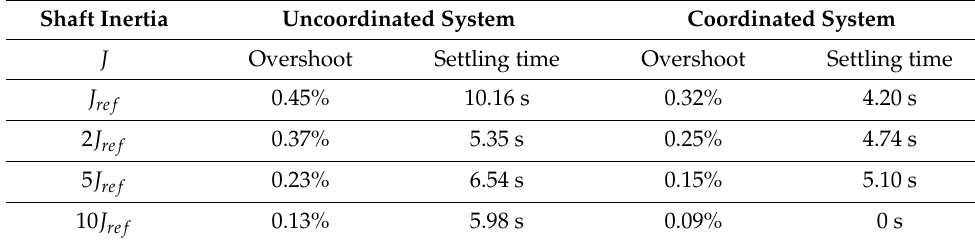
Table 4. Overshoot and settling time at Transient #3 vs. shaft inertia of the LP spool. Shaft